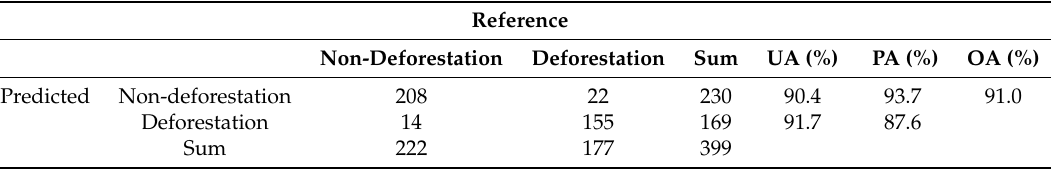
Table 2. Error matrix between reference data and GFW annual forest cover change map.